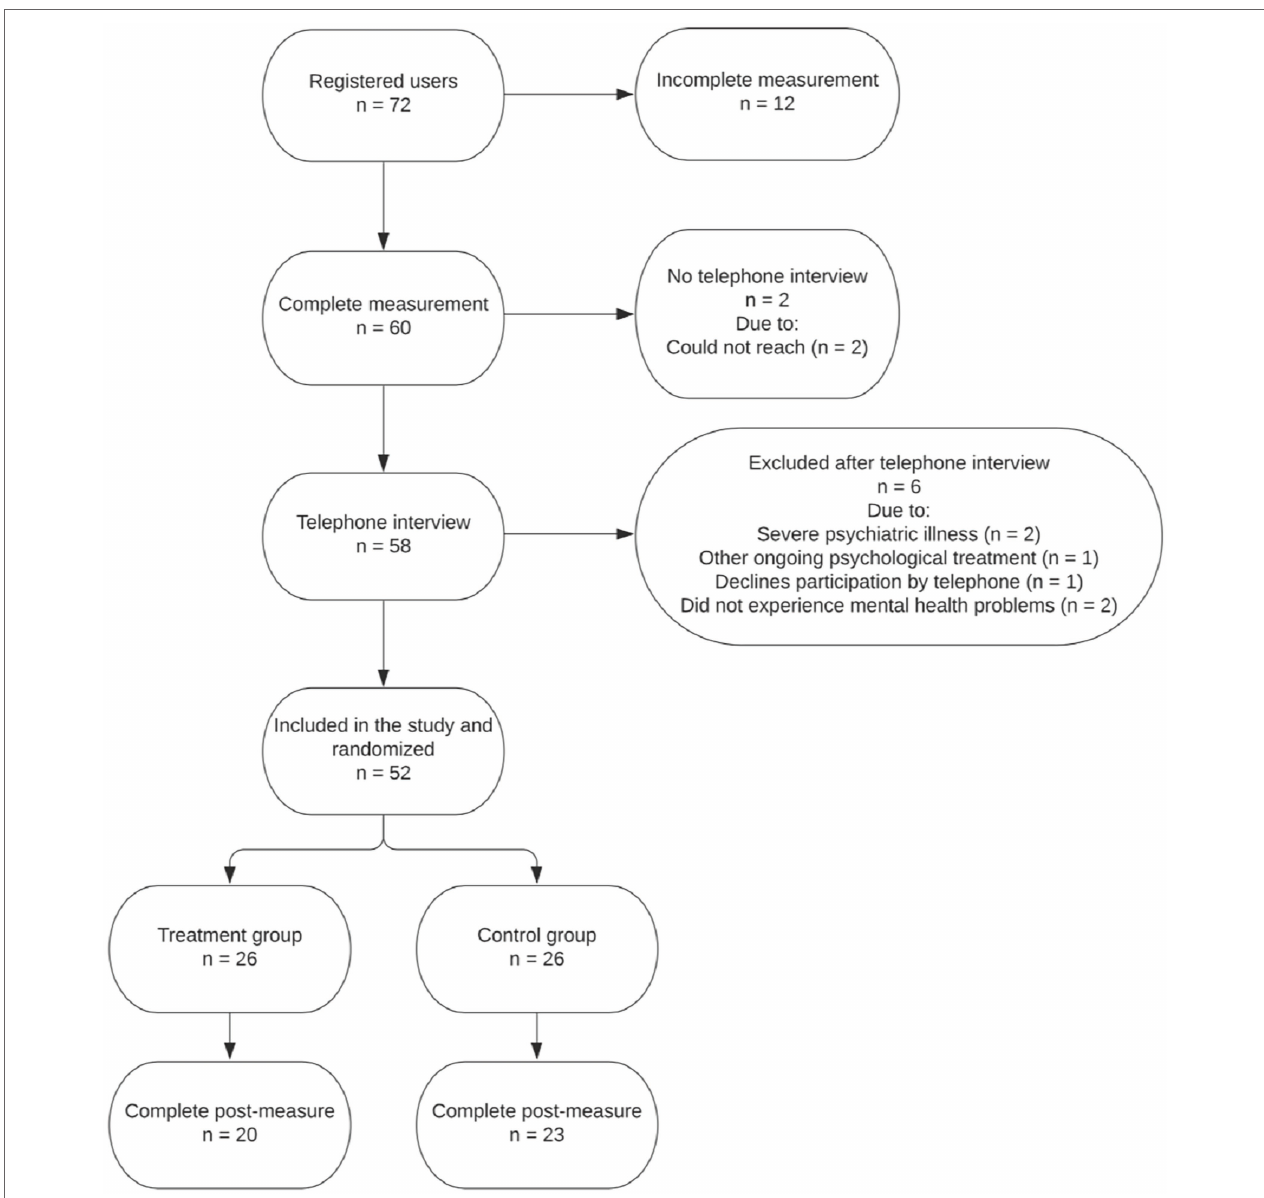
FIGURE 1 | Flowchart of the progress from registration to